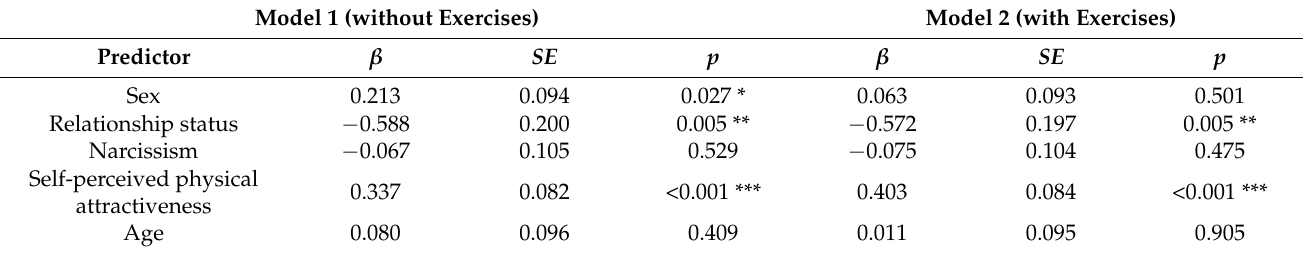
Table 2. Results of multilevel models, with daily diary entries nested within participants and random effects for